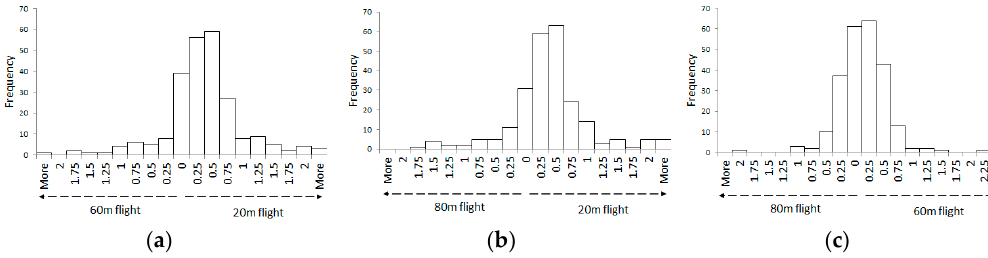
Figure 12. Histogram of difference for tree height between different flight altitudes: ( a ) 60 m and 20 m, ( b ) 80 m and 20 m, and ( c ) 80 m and 60 m.